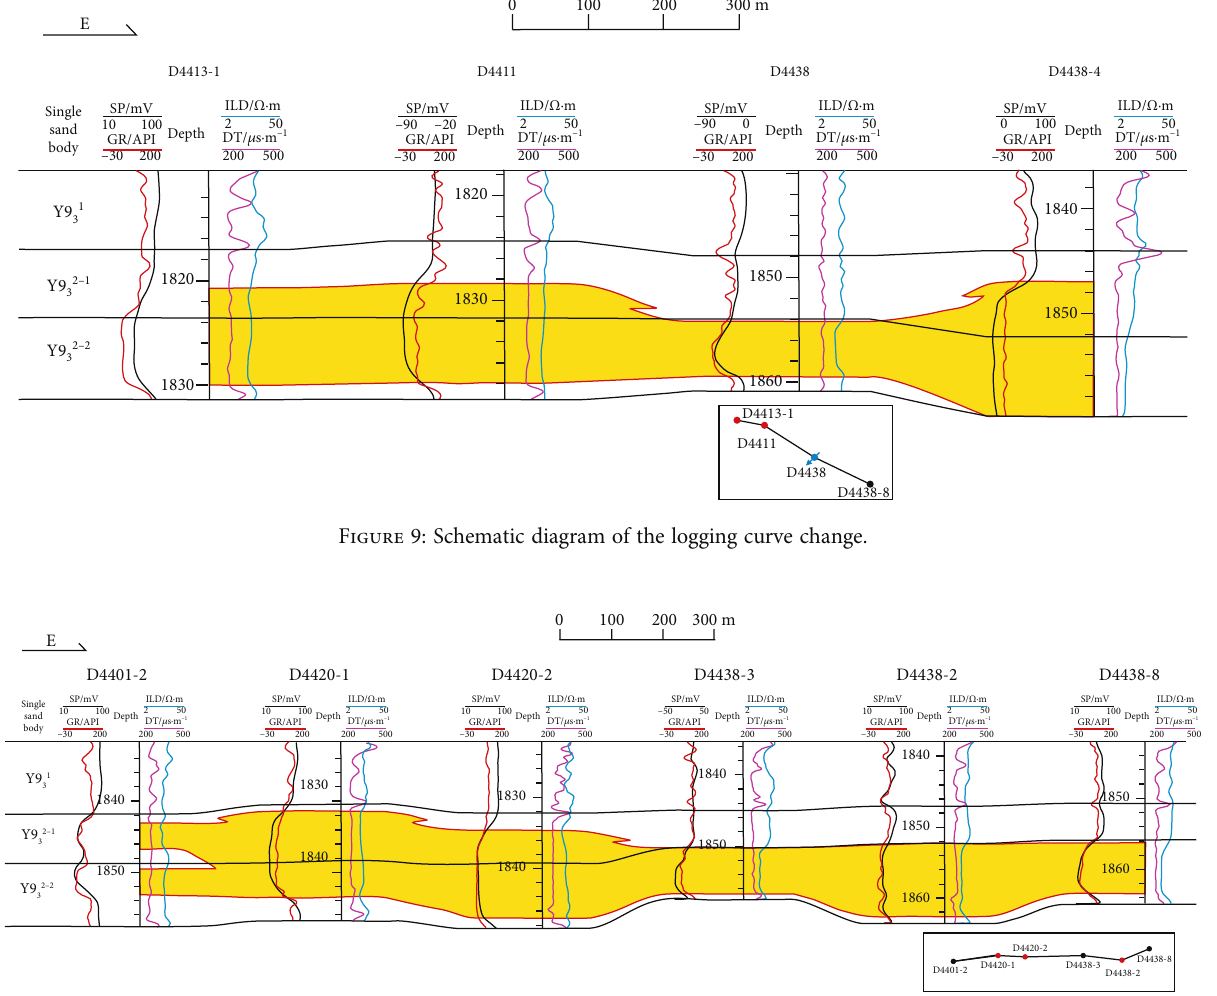
Figure 10: Schematic diagram of sand body thickness change.